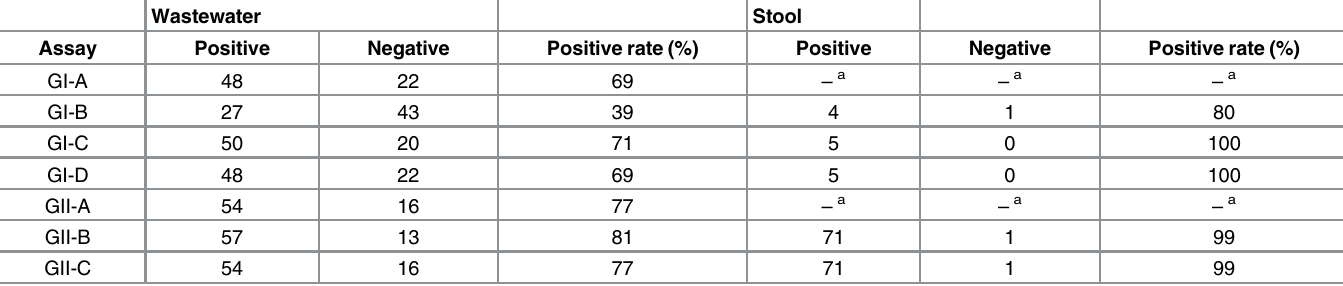
Table 2. Number of positive/negative samples and the corresponding positive rates for each assay using wastewater or stool samples.